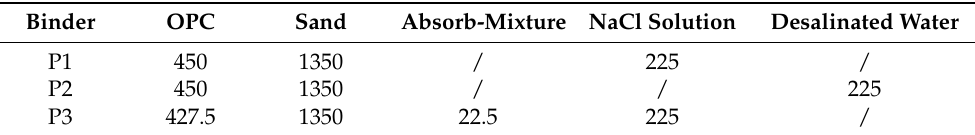
Table 1. Mix proportions of cement mortar